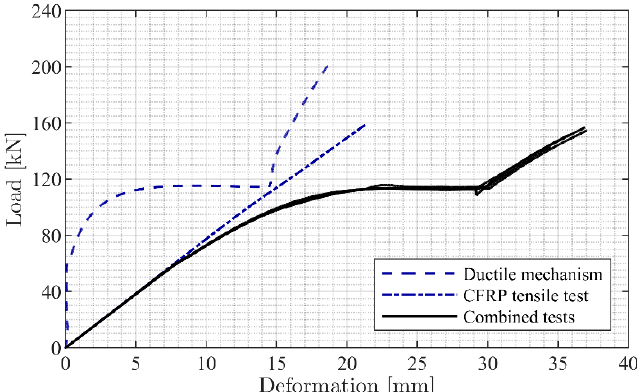
Figure 1. Increased ductility in the combined system response